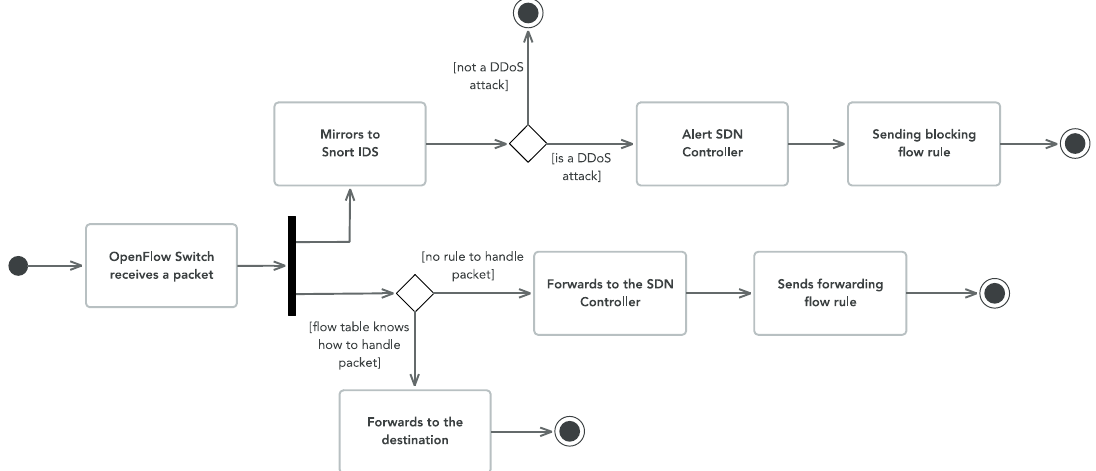
Figure 4. System Workflow for Each Received Packet.